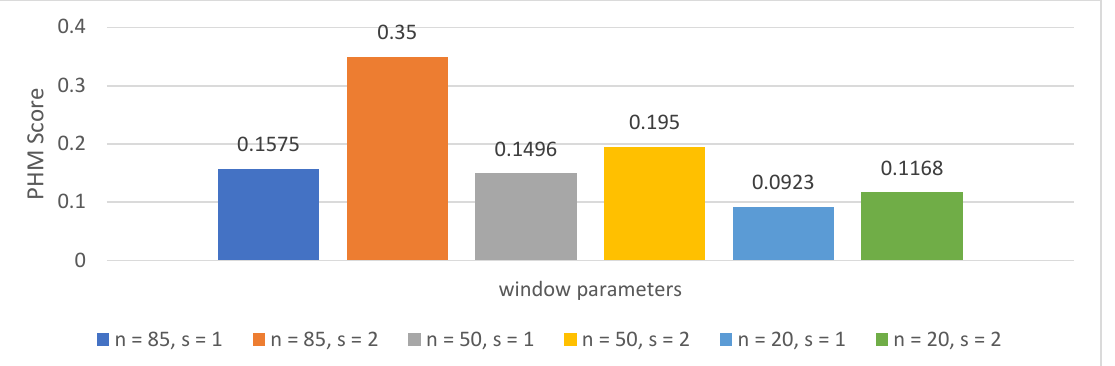
Figure 9. Evaluation of different numbers of used steps ( n ) and step sizes ( s ) for the training of the proposed RUL framework. The best result is achieved with an input size of 85 and a step size of 2.